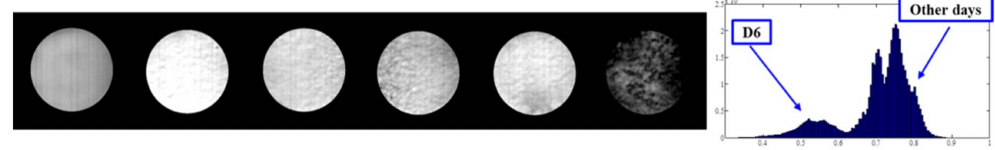
Figure 4. Image of A. parasiticus at 520 nm.